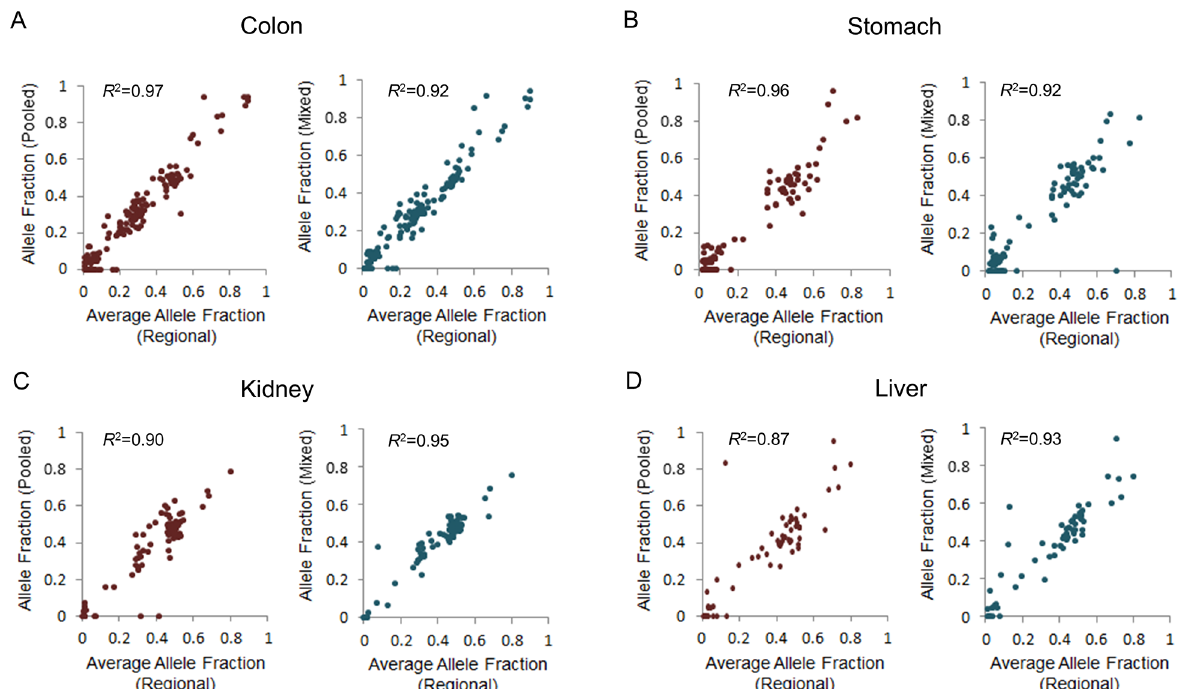
Fig 3. Correlation between the average variant allele fraction of regional samples and the allele fraction of pooled sample (or the in silico mixed